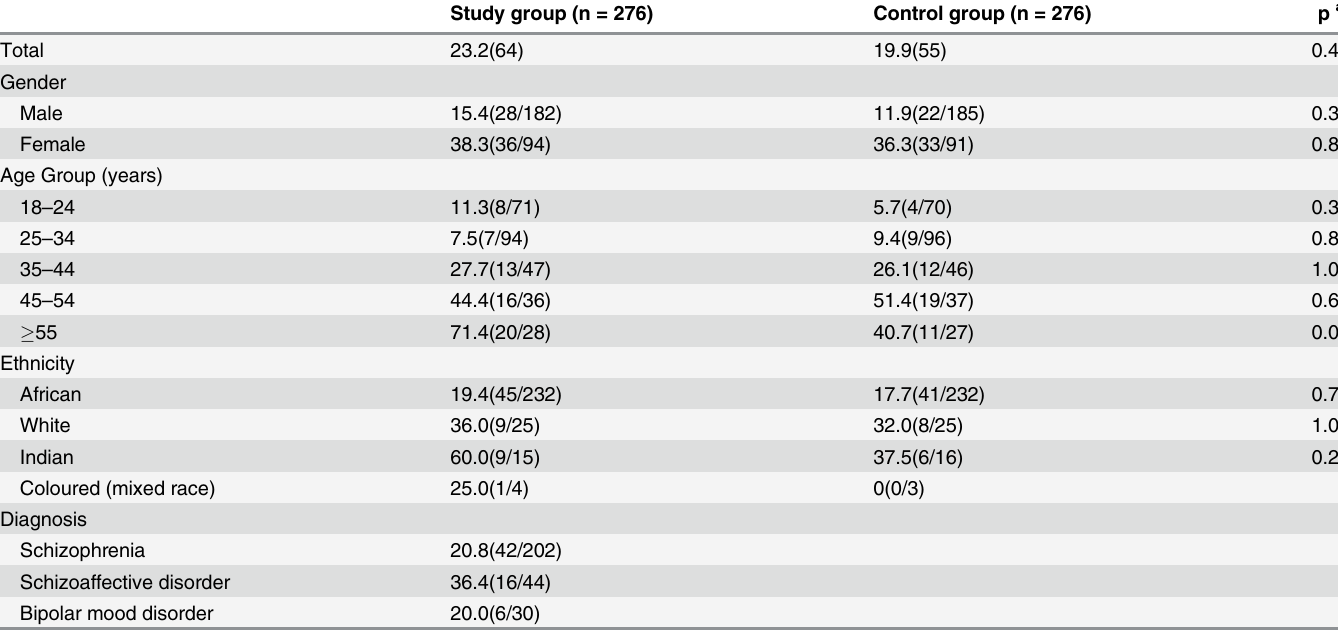
Table 2. Prevalence of metabolic syndrome by demographic characteristics and diagnosis in the study and control